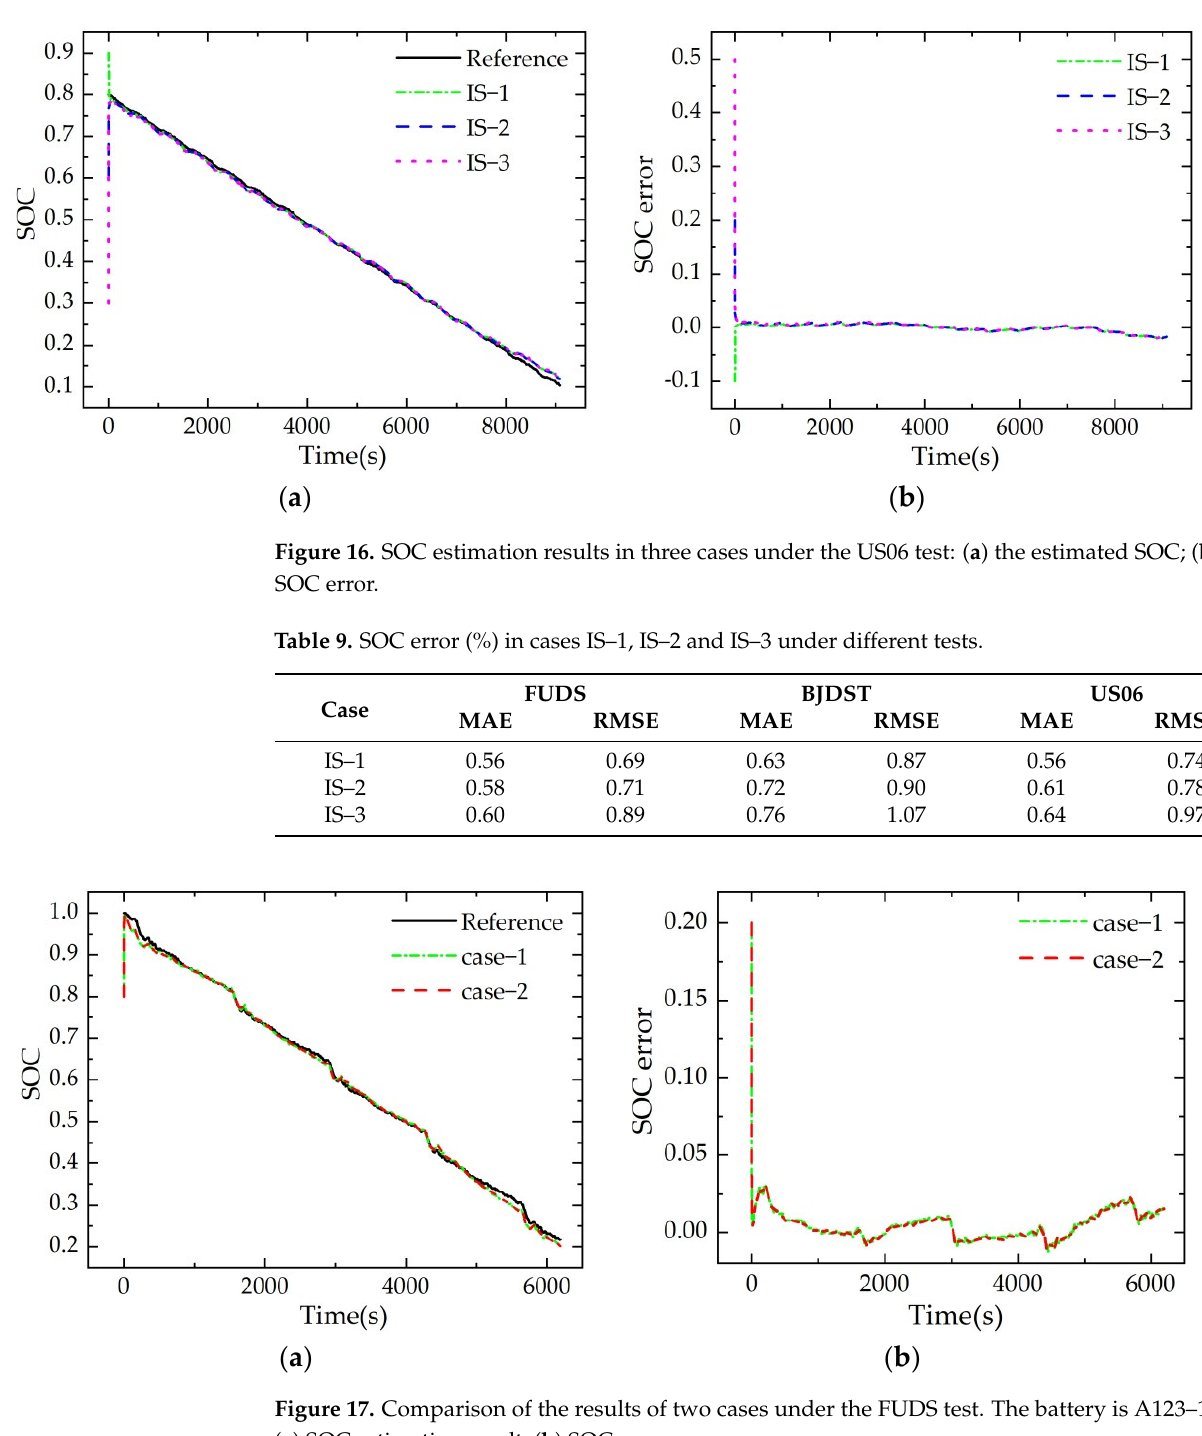
Figure 15. SOC estimation results in three cases under BJDST: ( a ) the estimated SOC; ( b ) the SOC error.